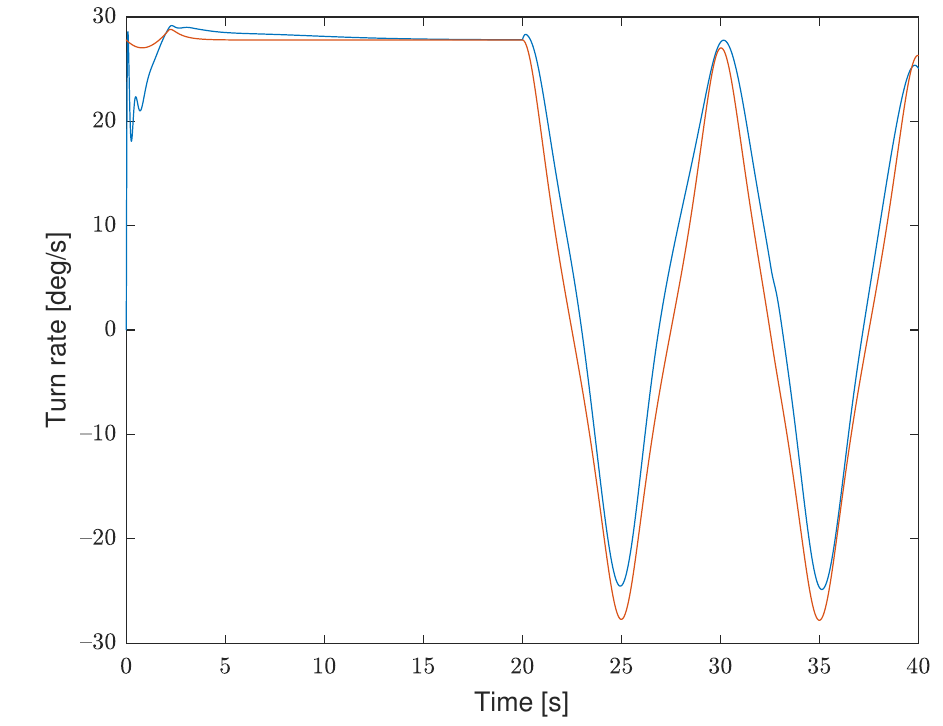
Figure 7. Magnitudes of ω (cid:107) (red) vs. ω